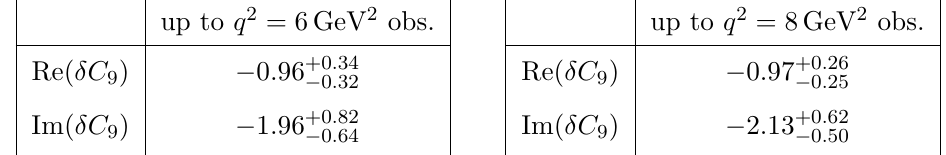
in general it is true that as long as the NP (cid:12)t is embedded in the more general